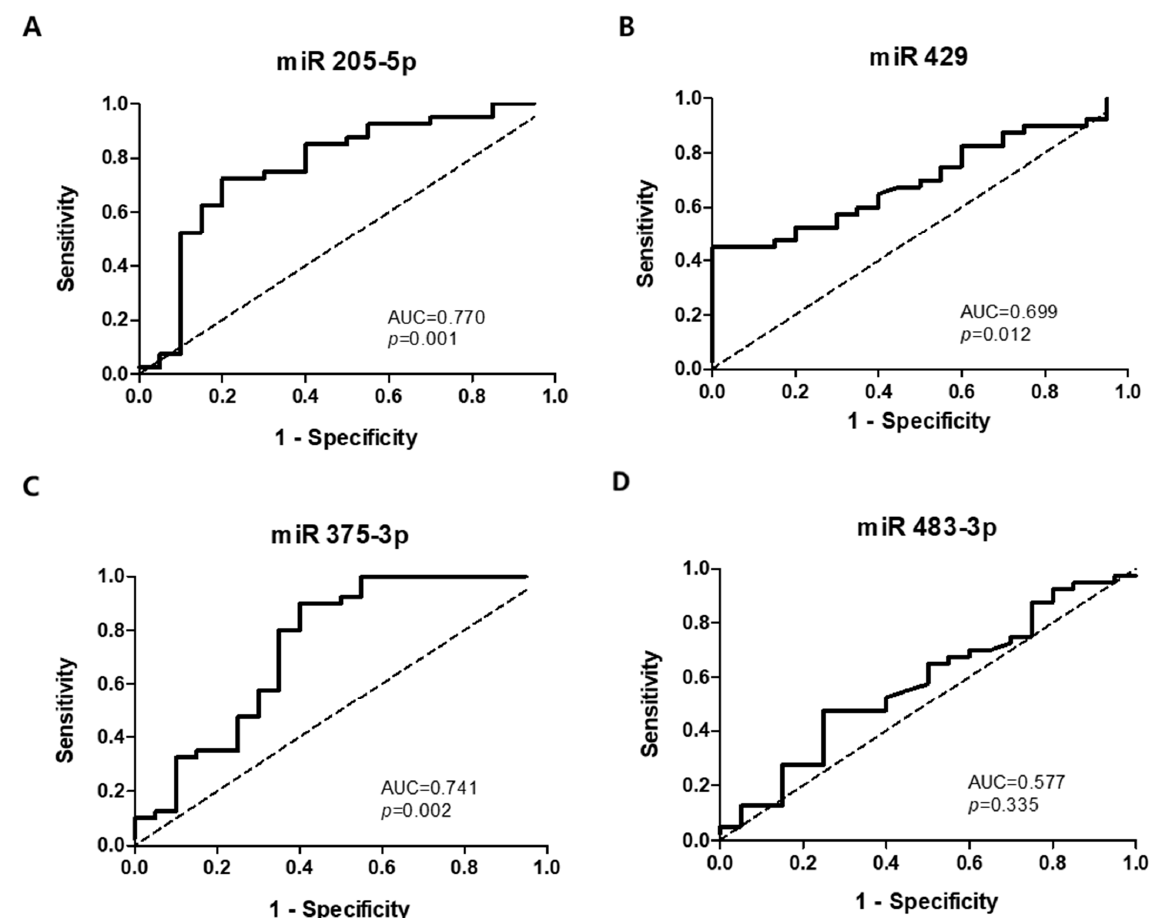
Figure 6. Receiver-operating characteristic curve analyses of four plasma exosomal miRNAs to dif- ferentiate patients with esophageal squamous cell carcinoma from healthy controls. ( A ) miR-205-5p. ( B ) miR-429 ( C ) miR-375-3p. ( D ) miR-483-3p. AUC, area under the curve.